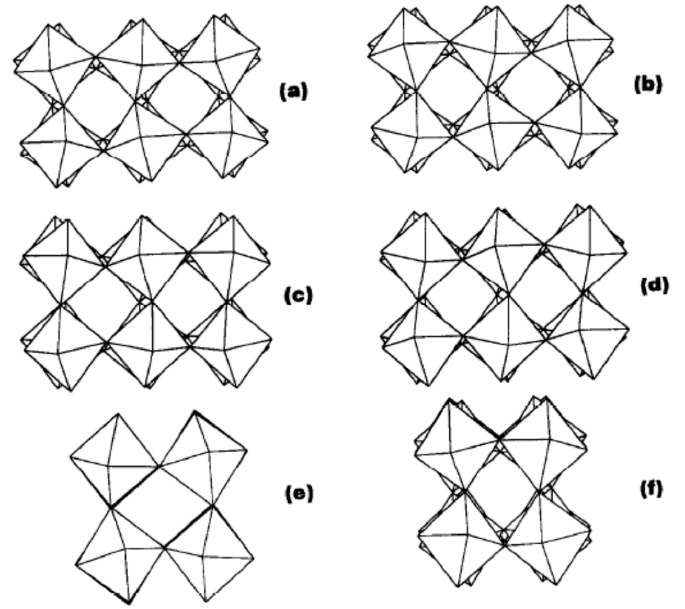
Figure 2. Tilt patterns of WO 3 : ( a ) monoclinic (001) projection, x -axis vertical; ( b ) triclinic (001) projection, x -axis vertical; ( c ) monoclinic (100) projection, z -axis vertical; ( d ) triclinic (100) projection, z -axis vertical; ( e ) monoclinic (010) projection, z -axis vertical; ( f ) triclinic (010) projection, z -axis vertical. Figure and caption reprinted from ref. [83]: J. Phys. Chem. Solids, Vol. 56, No. 10.